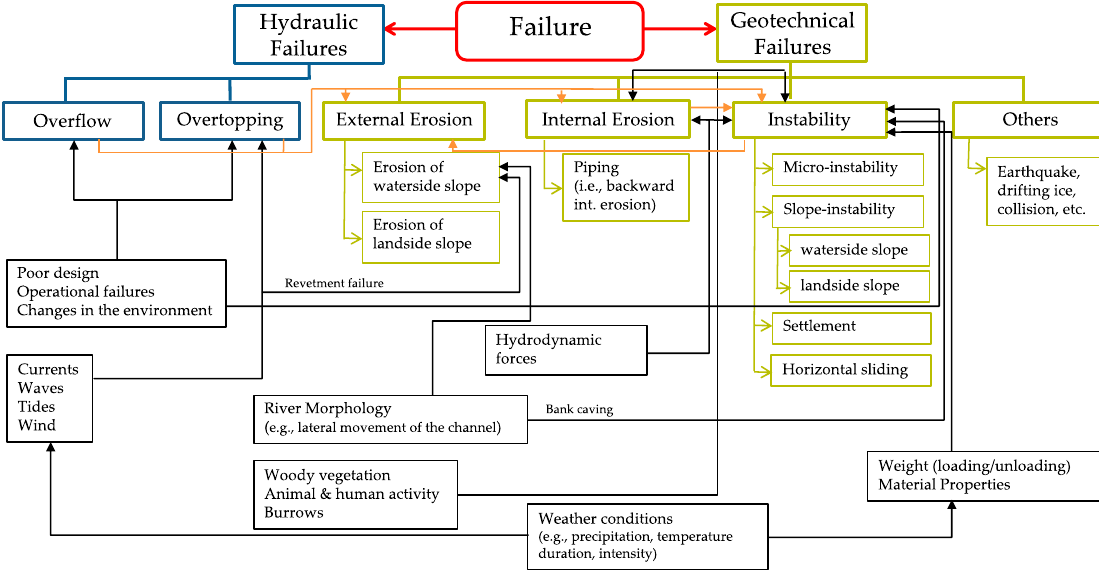
Figure 3. An overview of most relevant levee failure mechanisms and their most common contributing factors [9,31].